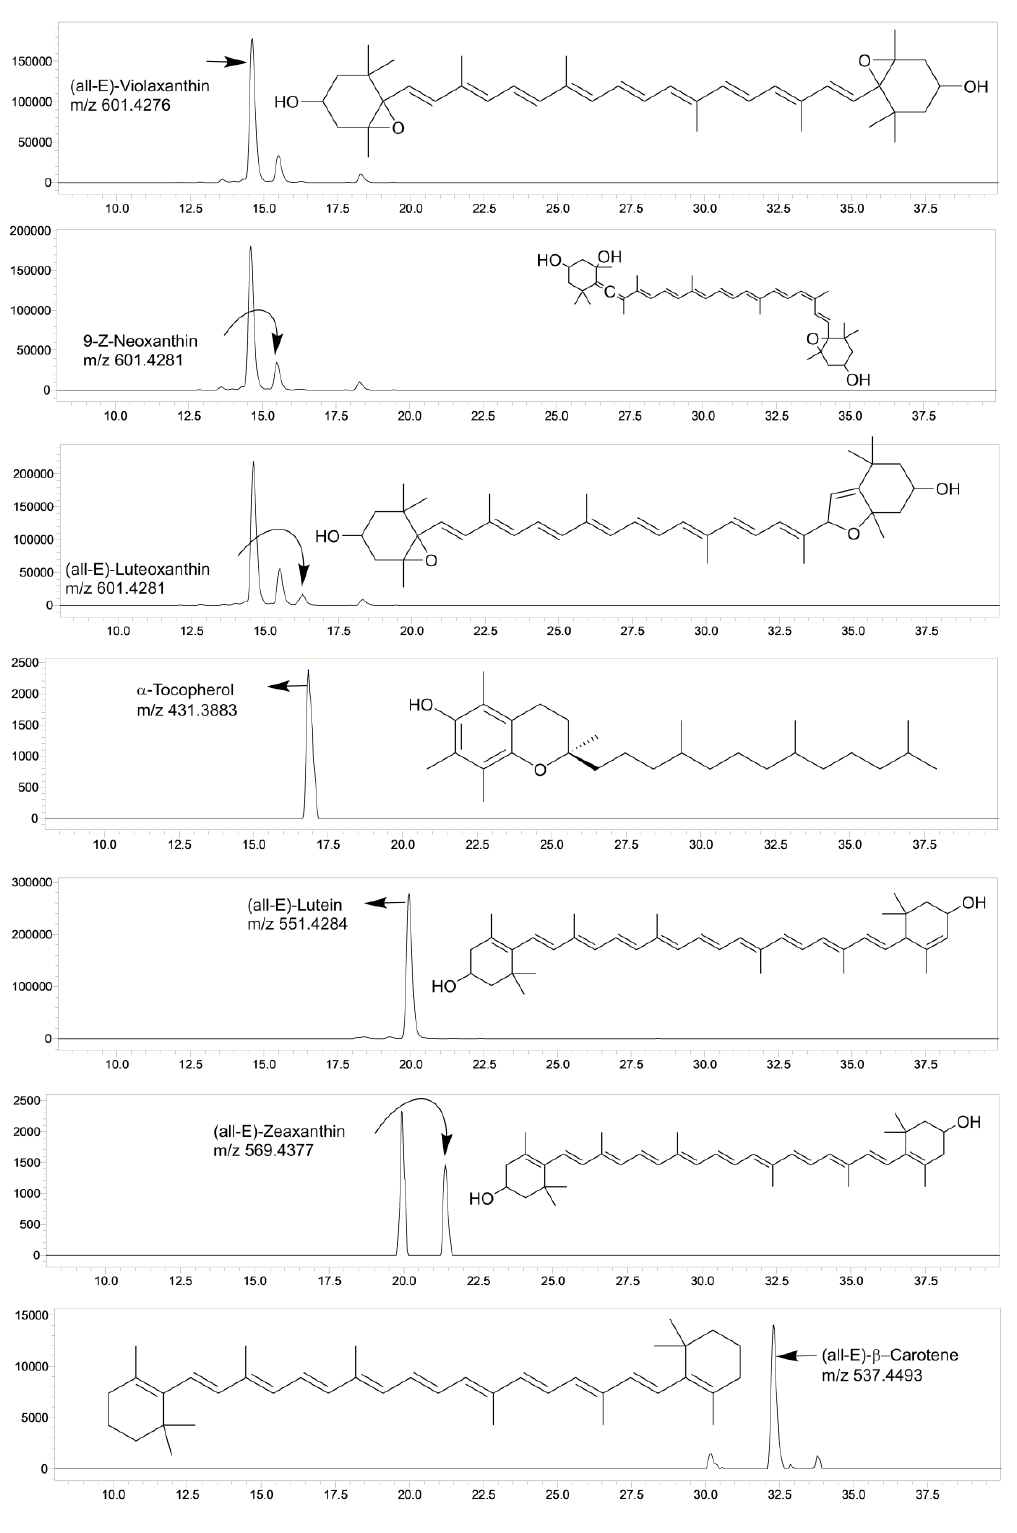
α -tocopherol detected